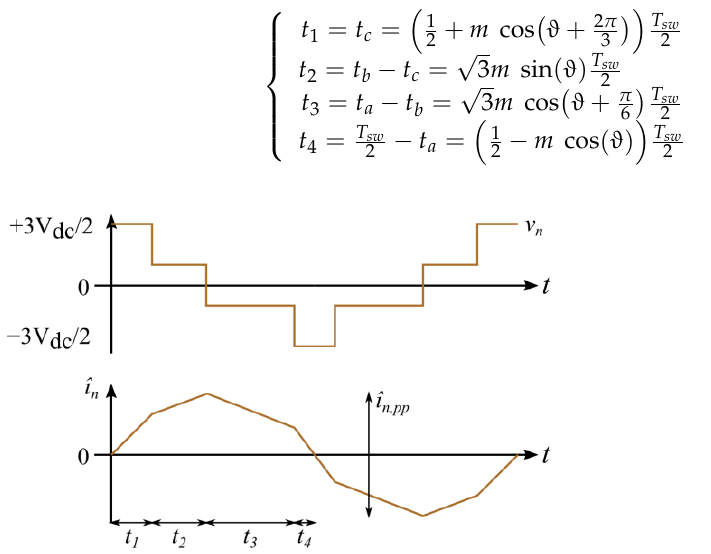
Figure 7. Sum of the inverter phase voltages v n ( top ) and neutral current ripple ˆ i n ( bottom ) in one switching period in the case of balanced SPWM. Application time intervals and neutral current ripple peak-to-peak definition.